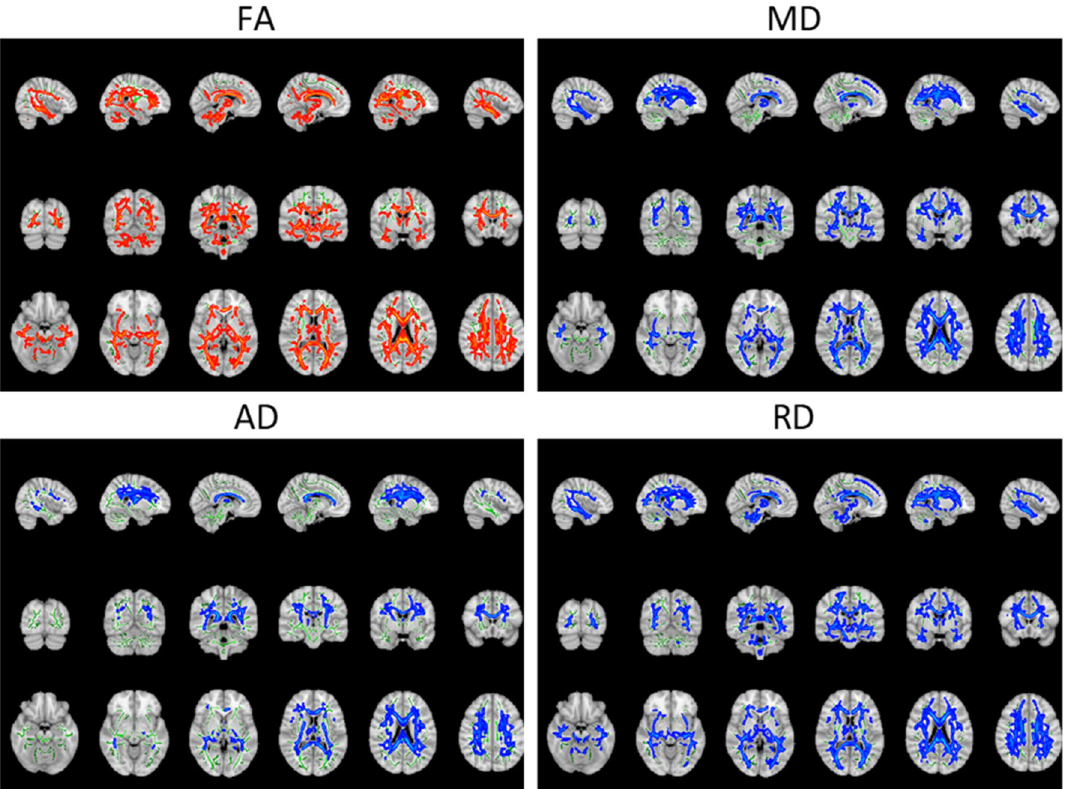
Figure 1. Tract-based spatial statistics nonparametric permutation inference results of comparing the diffusion tensor parameters of PwMS and HS. For better visualisation purposes the results are projected on top of a standard MNI image, with the assessed IIT-FA-skeleton shown in green and the significant outcomes thickened. Regions in red and blue respectively indicate a significant decrease or increase of the diffusion tensor parameter in PwMS compared to HS. For better visualization, the data can be visualized in 3D in the repository: https:// neuro vault. org/ colle ctions/ LYEGO WBT/.